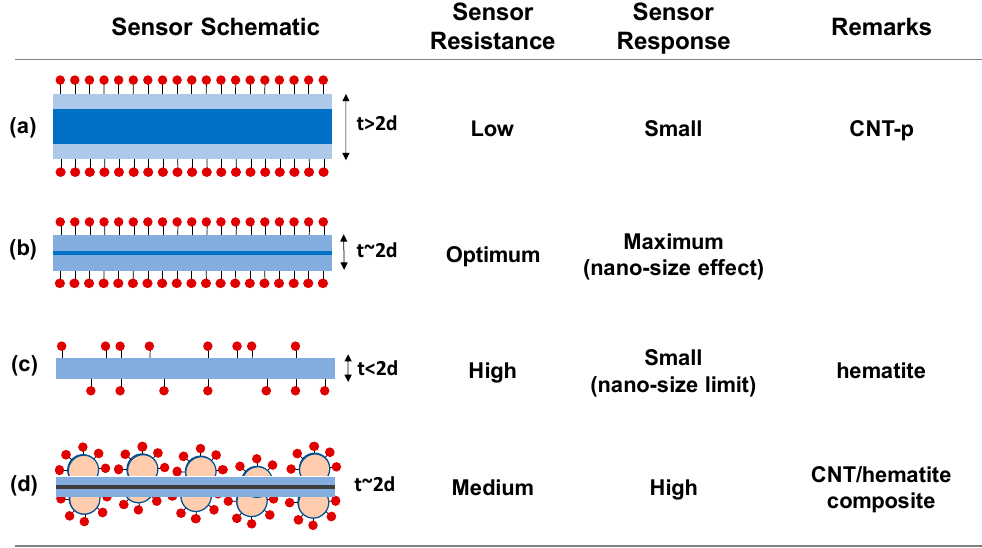
Figure 6. The schematic showing nanostructured sensor conditions with different performance. ( a ) The structural dimension of the sensor material is far greater than the depletion depth. The response is small due to too high conductance by the great conduction region. ( b ) The dimension of the structure approaches the depletion depth, which is the condition of the maximum nano-size effect in sensing. ( c ) The dimension of the structure is smaller than the depletion depth. Too high resistance leads to the negligible modulation of the resistance followed by the small response during chemisorption on the sensor. Note the surface adsorption sites are all occupied in the condition of (a) and (b), but are partially occupied in (c) due to the limited charge carriers in the structure. ( d ) The increase in both charge carriers and adsorption site density in optimized composite structures can reveal the high sensing capability like the condition of (b).